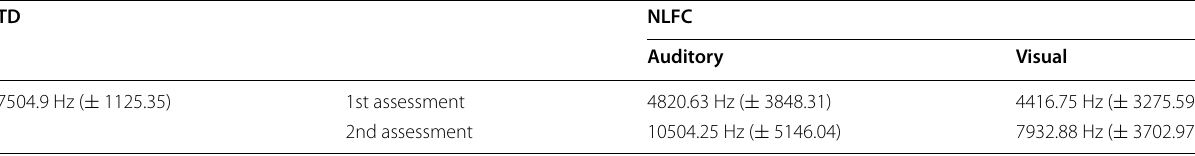
Table 3 Mean of F2 onset in /si/ syllable in TD and NLFC groups